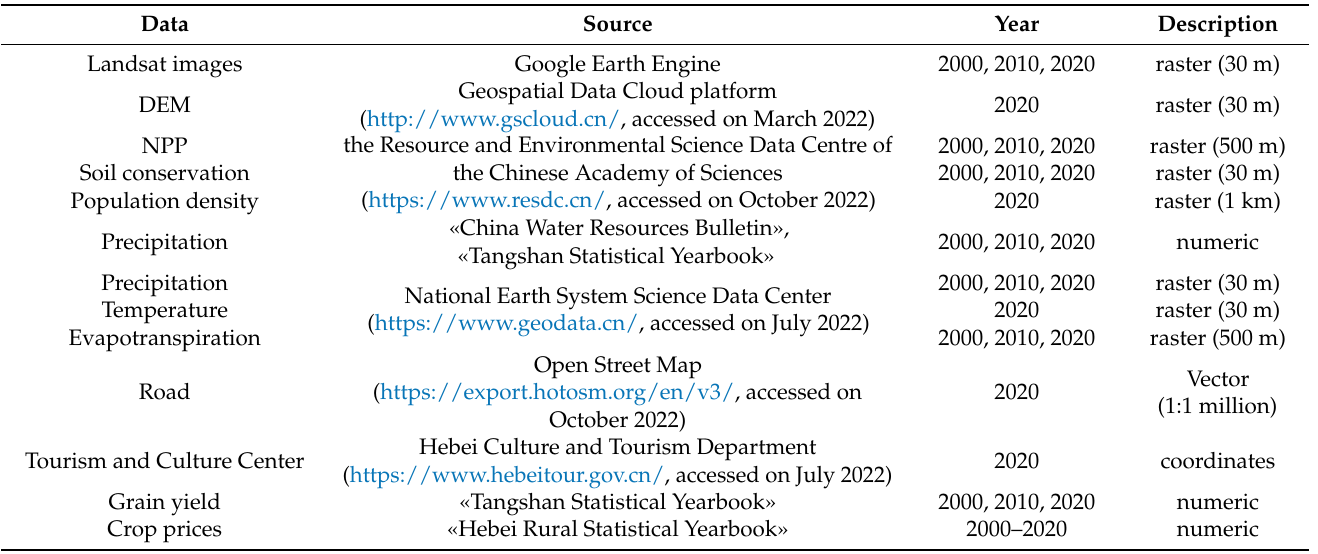
Table 1. Data sources and description.